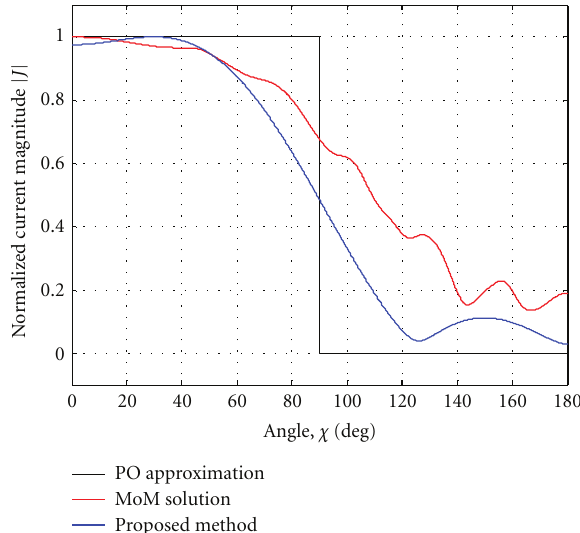
Figure 8: Surface current densities on an infinite cylinder surface at f = 3GHz.